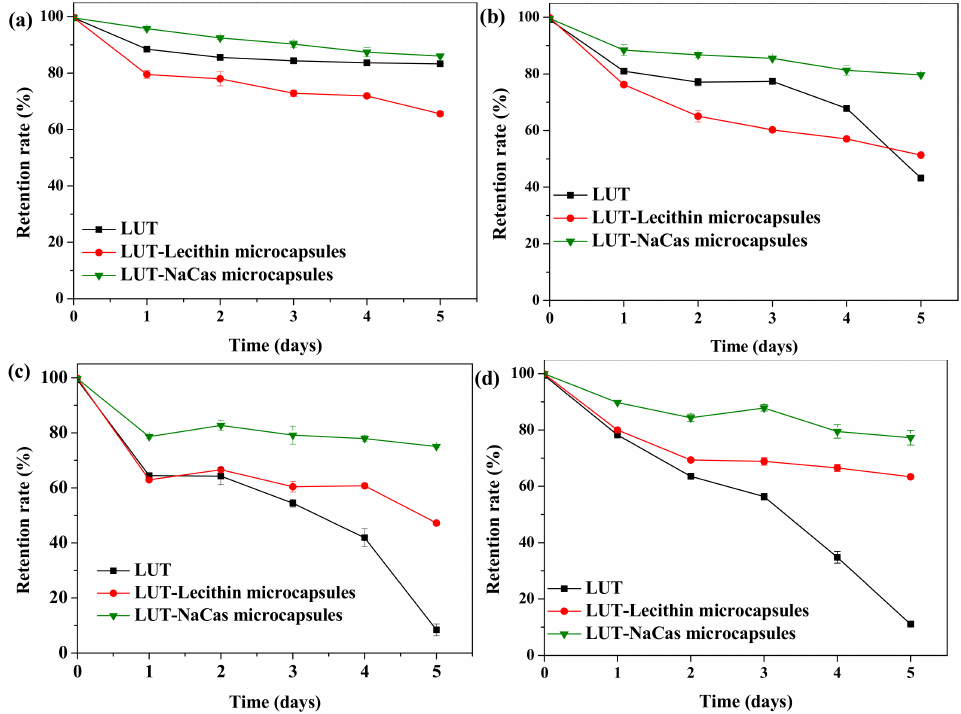
Figure 2. Effect of storage conditions on retention rate of lutein (LUT) in its native form and in microcapsules, ( a ) 4 ◦ C in dark, ( b ) 25 ◦ C in dark, ( c ) 37 ◦ C in dark ( d ) 25 ◦ C in bright sunshine. Data points represent means (n = 3) ± standard deviations. Some error bars lie within the data